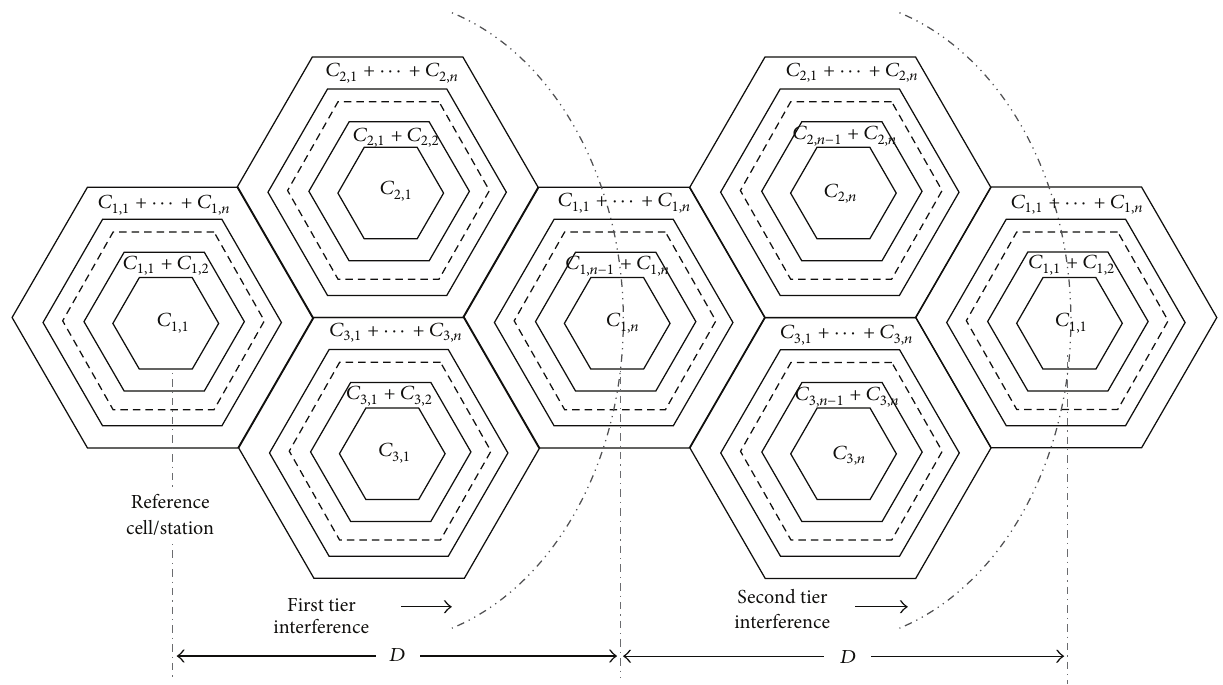
Figure 2: The structure of the adaptive multibeam antenna hierarchical cellular